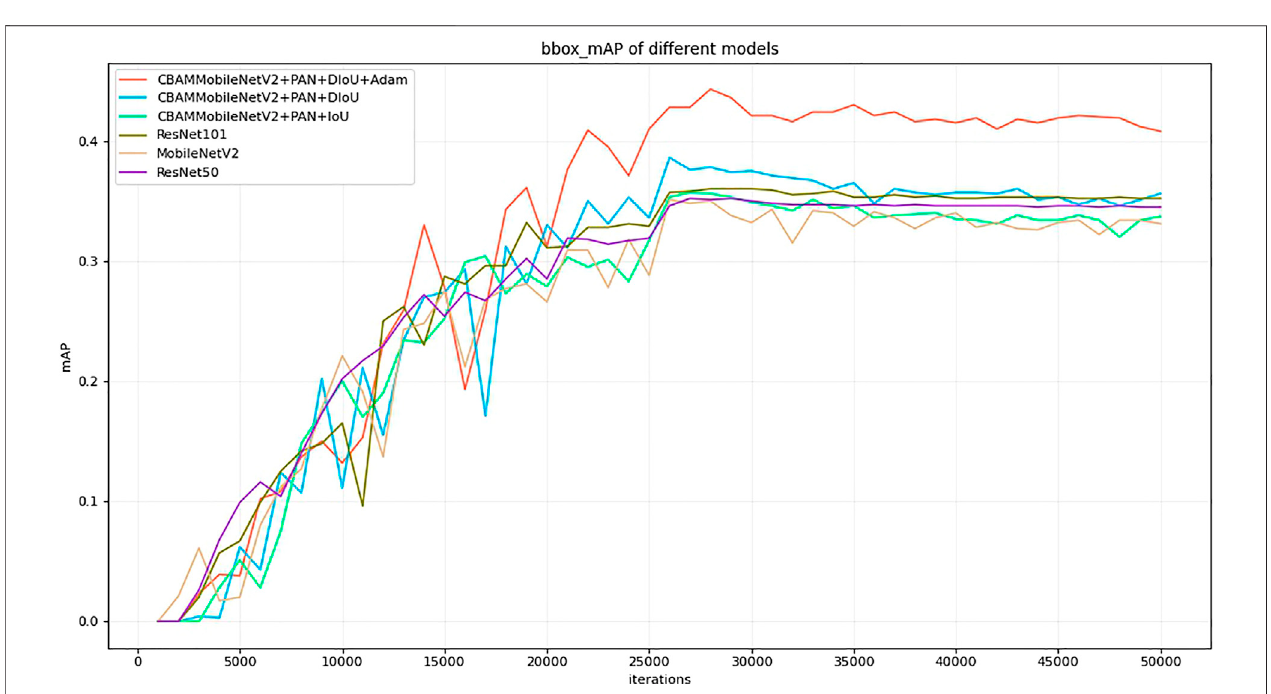
FIGURE 8 | Comparison of mAP curves during test of different models.